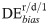
First (best), fifth (near median) and last summary attainment surfaces for the 10 × 10 problem using normal DE, DEbias, DEbiasr/d/1 and DEbiasr/d/3*.Best, second best and worst of the three ACO result sets are plotted independently, in that order.